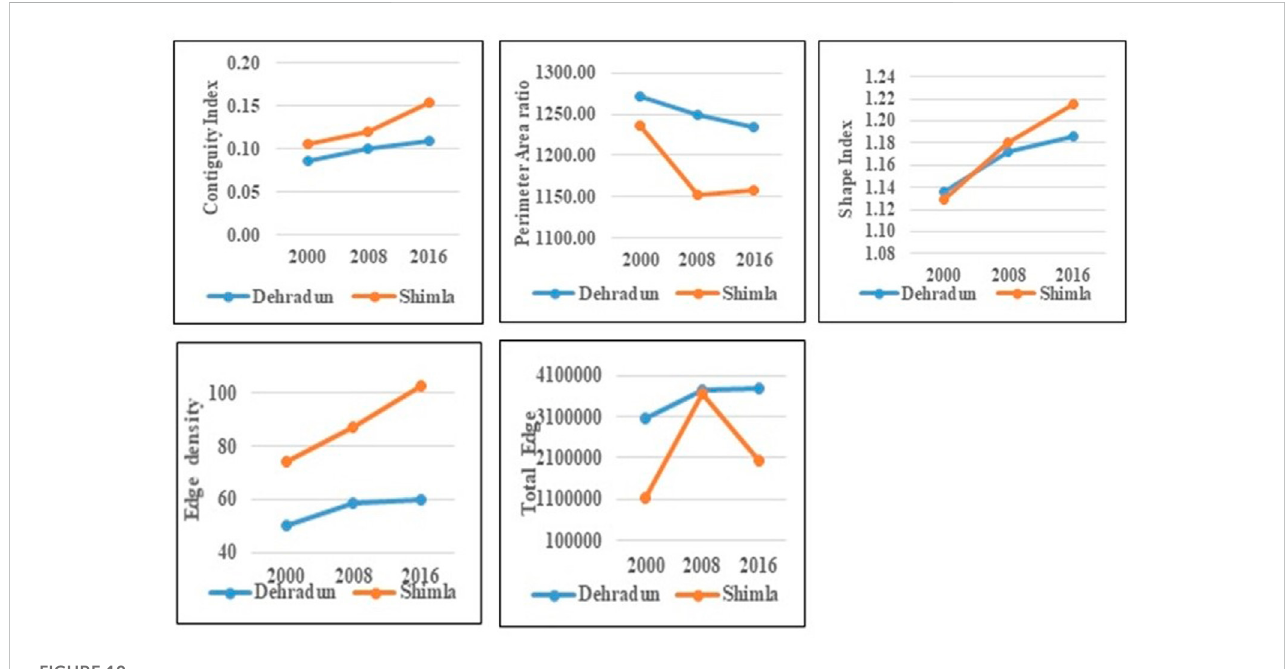
FIGURE 10 Changes in spatial metrics at Class level for Dehradun and